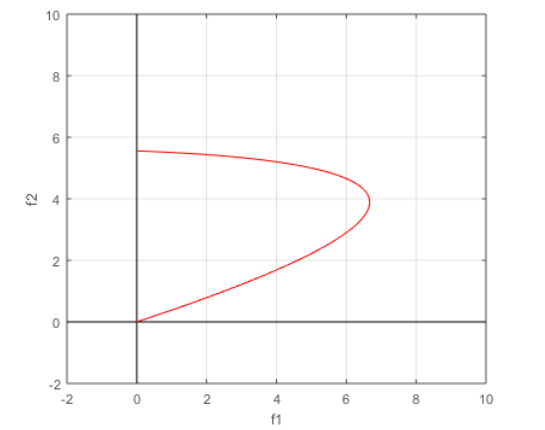
Figure 2. Representation of vector family v µ : C → R 2 : z (cid:55)→ µ ( z , z 2 ) as a parametric